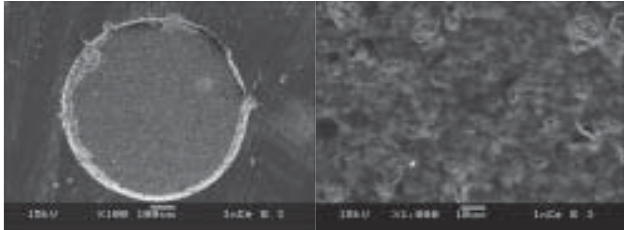
Fig 4. SEM of In-Ceram Alumina: Adhesive fracture pattern (arrow) (A- Original magnification X 100; B- Original magnification X 1000).